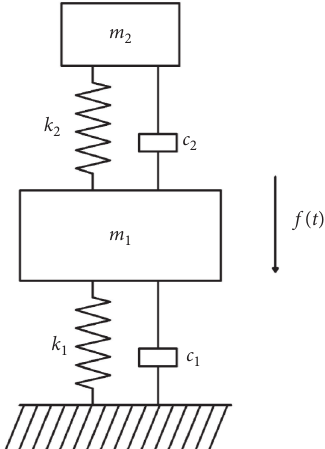
Figure 2: Diagram of an SDOF structure with an installed